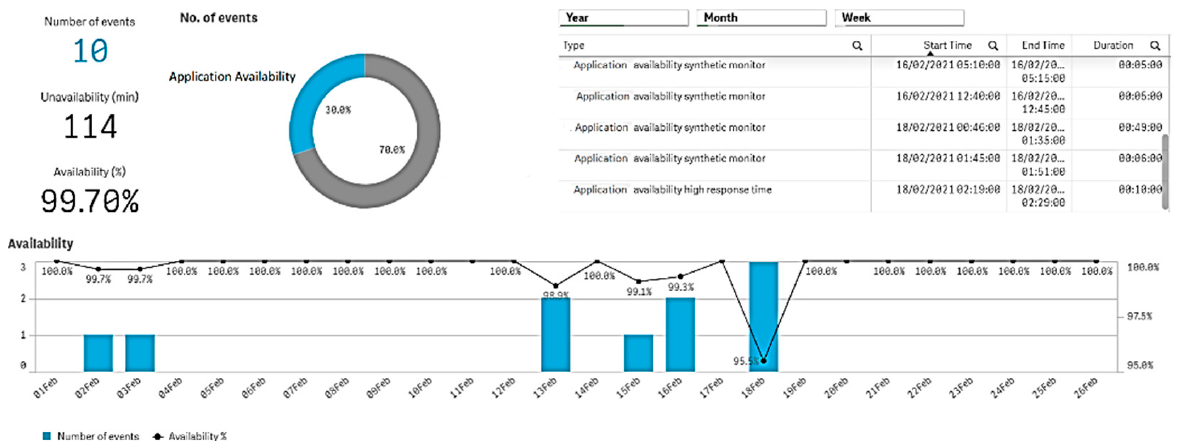
Figure 5. Displayed information regarding the availability of an application.